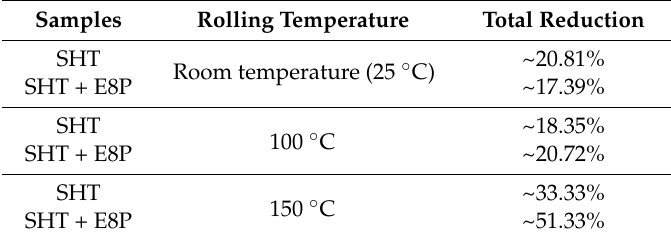
Table 1. Rolling reduction comparison of the solution heat treated (SHT) and SHT + equal channel angular pressing (ECAP) 8-p processed samples at different rolling